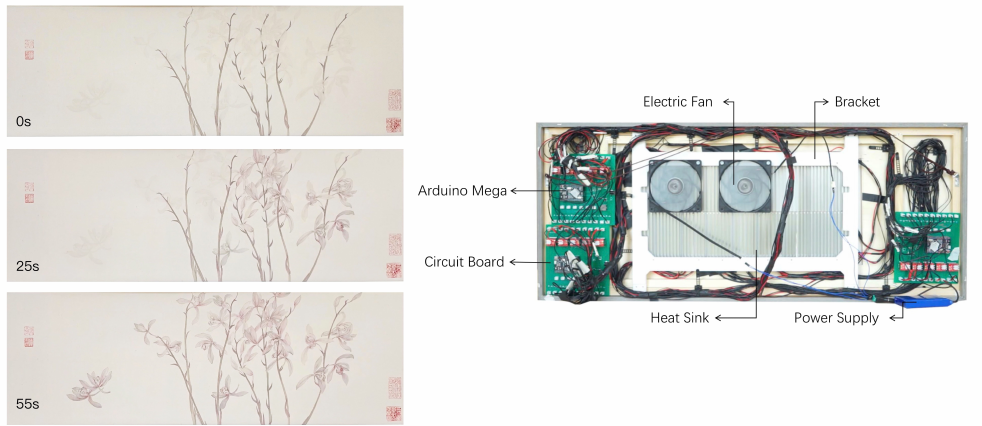
Figure 2. The artwork “Nine Orchids” (135 × 50 cm). The left picture shows three animation frames of the flower growth. The right picture shows a set of Peltier-based heating and cooling devices behind the painting. The device consists of 27 Peltier elements, 3 identical circuit systems, and a heat dissipation device. Each circuit system is mounted on a PCB which can control 10 Peltiers. It comprises an Arduino mega pro, five TB6612 driver chips, power supplies, and rectifier circuits. Each TB6612 driver can independently control two Peltier elements to cool and heat and support 1.2 A per channel. In addition, several heat sinks are used to cool the driver chips.